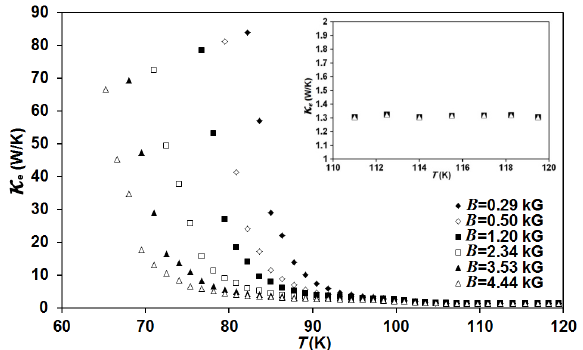
Fig. 12 Relation between magnetic field for (BaSnO 3 ) 0.75wt% /BiPb-2223 sample. The inset shows magnetic field independence of